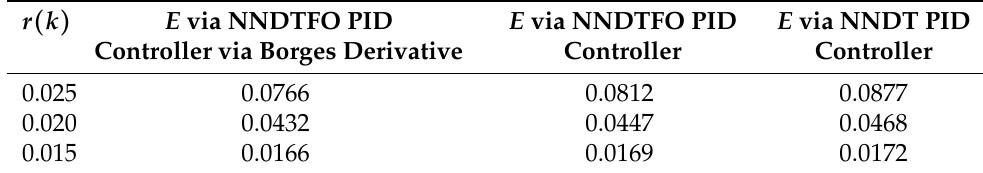
Table 4. Index E for constant reference signal via three types of controller.